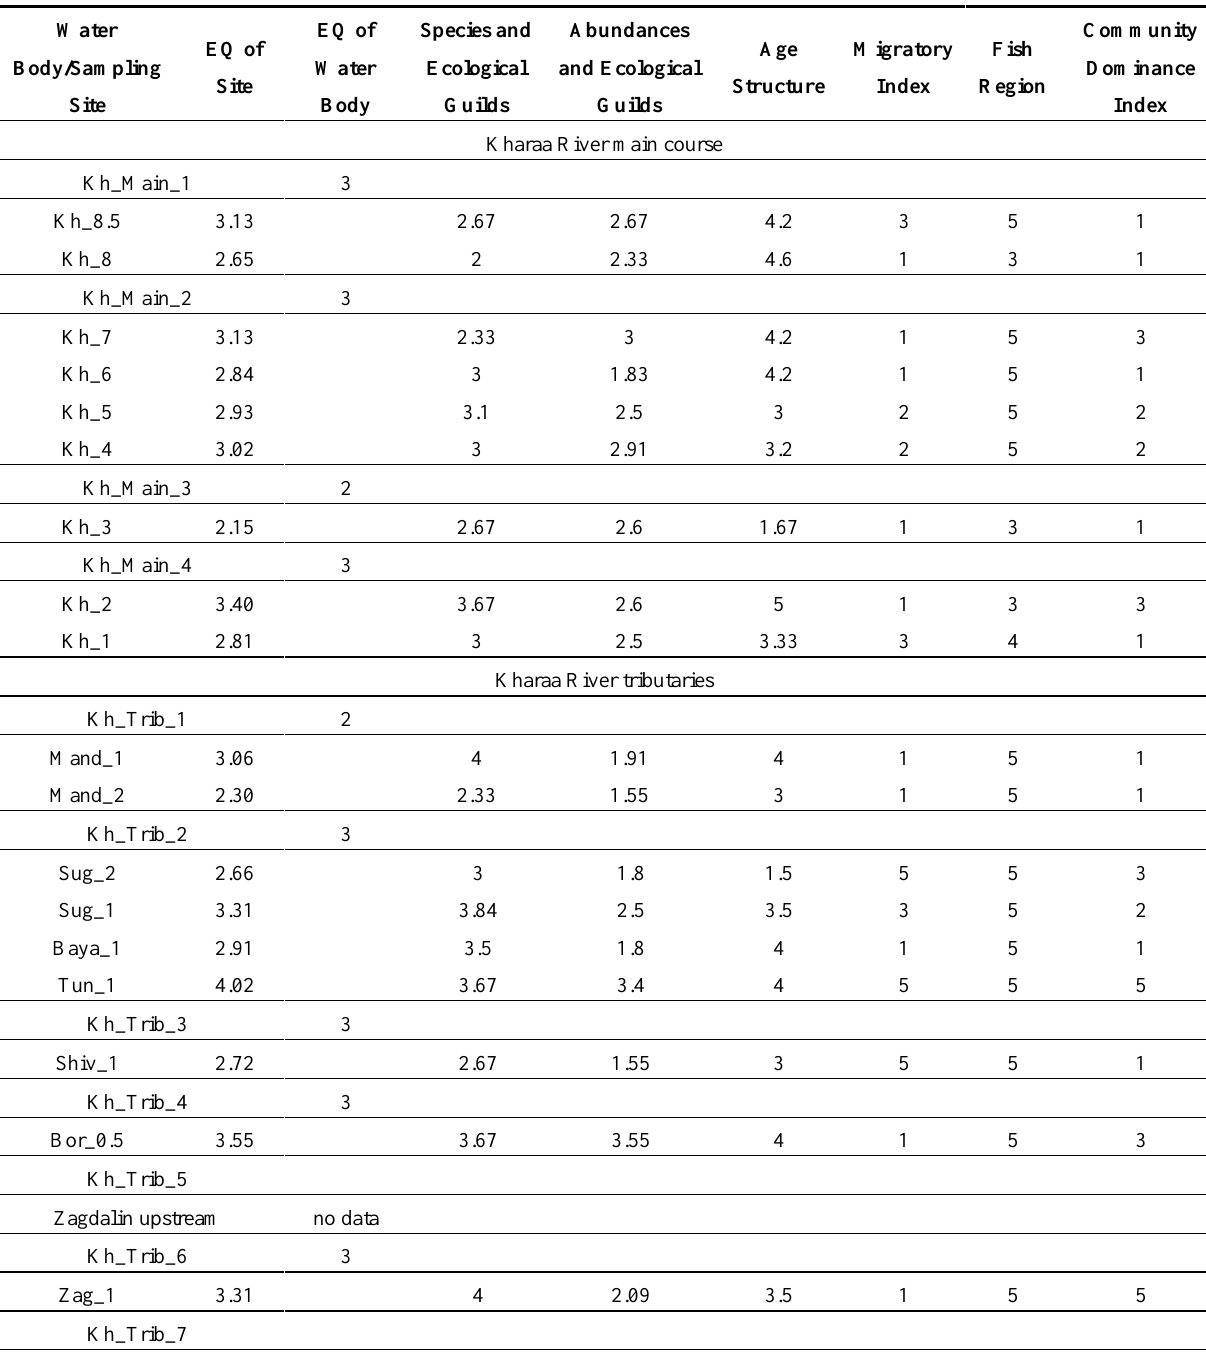
Table 10. The ecological assessment of fish fauna along sample sites in the KRB. The table shows the ecological quality metrics on a five step scale with 5 being “very good” and 1 being “bad”. Note that the evaluation scale (5–1) of Table 10 are inverted compared to the evaluation scale (1–5) of Table 9 due to the applied FIBS tool [59] (“species and ecological guilds” = occurrence of river type specific species, accompanying species, migratory species, habitat guilds, reproductive guilds and trophic guilds; “abundances and ecological guilds” = relative abundance of dominant species, relative abundances of perch/roach, distribution of ecological guilds; “age structure” = relative share of 0+